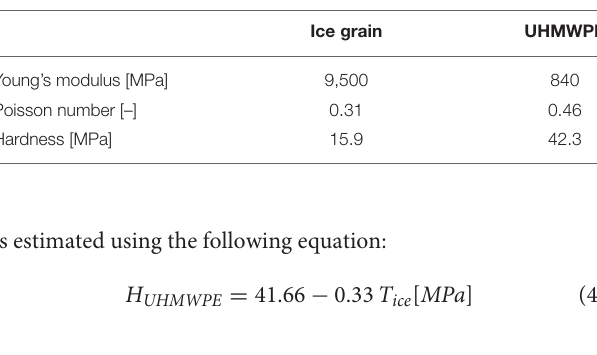
TABLE 2 | The mechanical properties of an ice grain in snow and the ski base material at T = − 2 ◦ C ( Poirier et al., 2011; Fellin, 2013; Böttcher et al.,